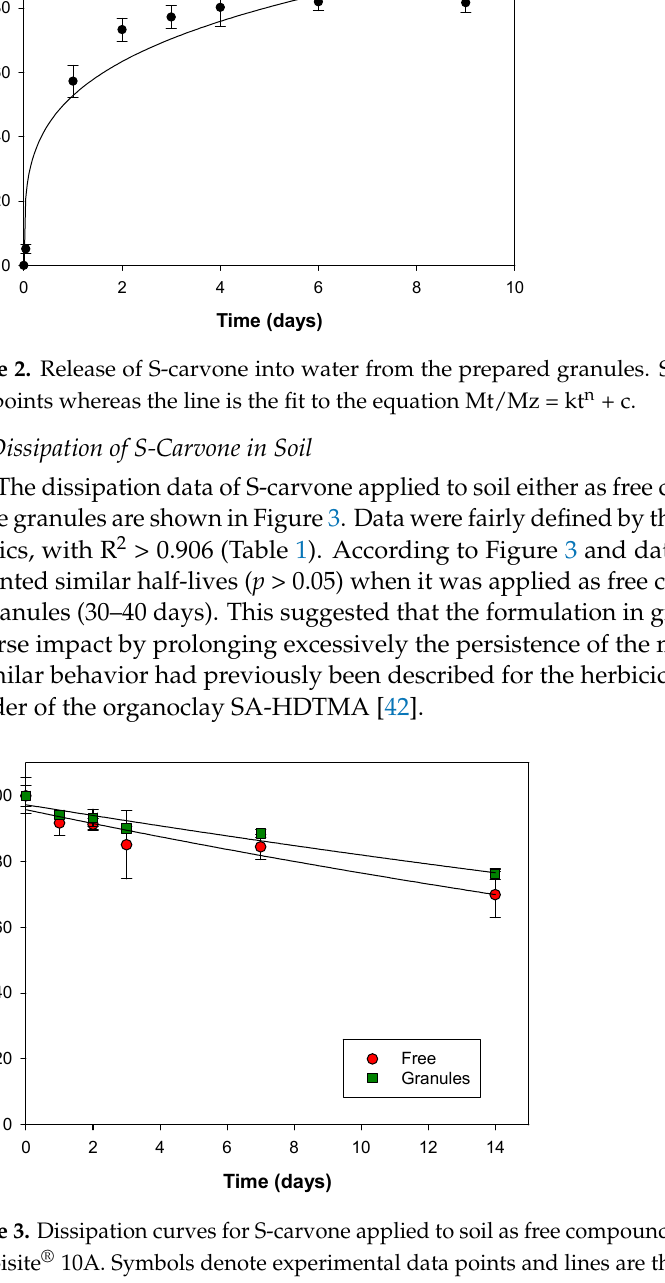
Figure 2. Release of S-carvone into water from the prepared granules. Symbols are experimental data points whereas the line is the fit to the equation Mt/Mz = kt n + c.